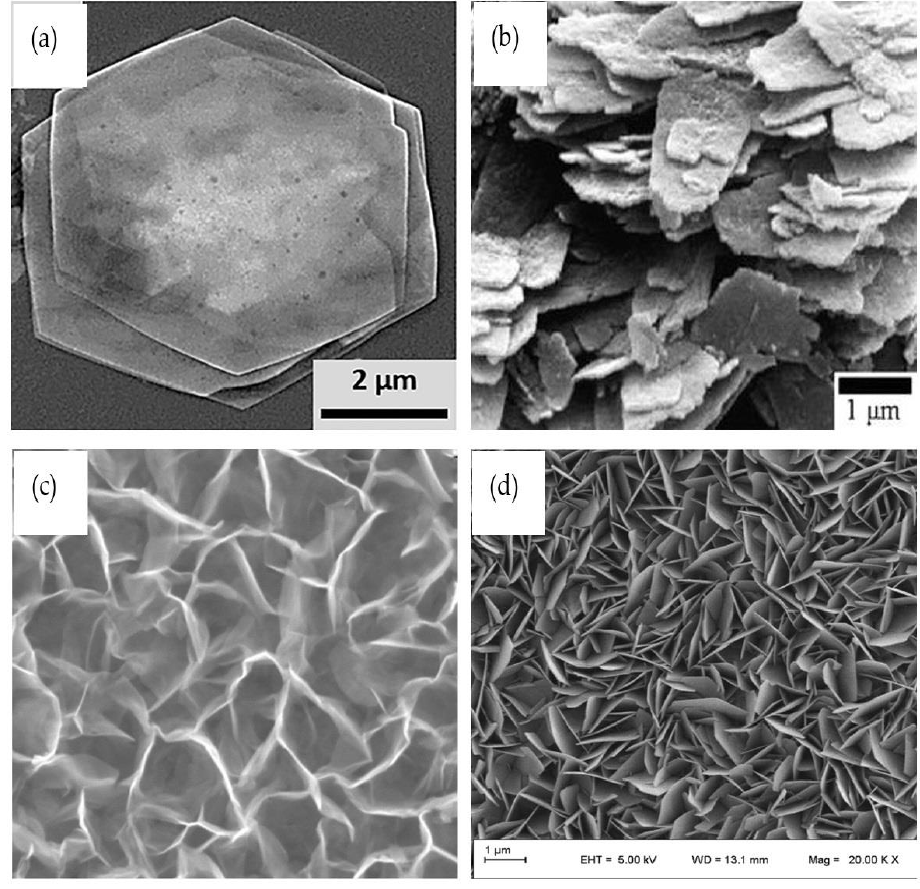
/ nanoflakes. Reprinted with permission from Figure 14. SEM image of 2-D ZnO ( a ) nanodisks/nanoflakes. Reprinted with permission from [121]. Figure 14. SEM image of 2-D ZnO ( a ) nanodisks